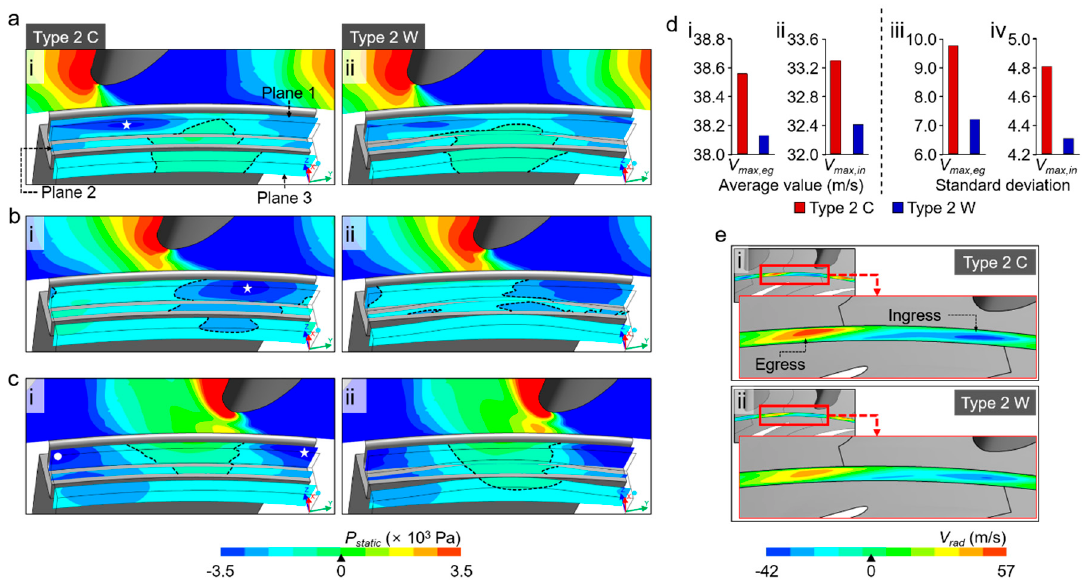
Figure 10. ( a – c ) Static pressure contours near the radial seal according to the rotation of the